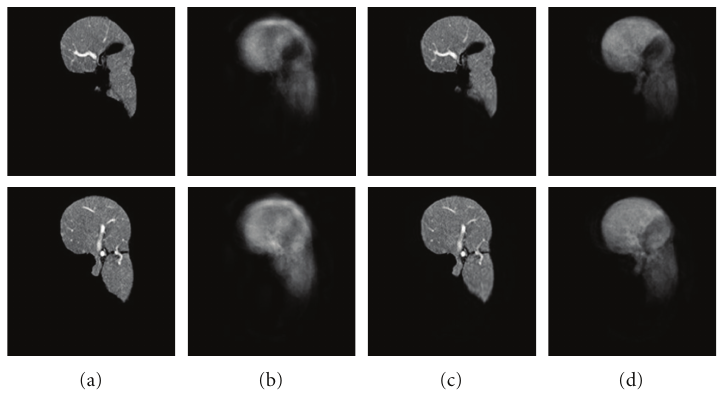
Figure 6: Reconstructed results for two slices of one test sample without shape normalization. (a) Original images. (b) Images reconstructed with 10 × 10 × 4 basis by GND-PCA. (c) Images reconstructed with 100 × 100 × 40 basis by GND-PCA. (d) Images reconstructed by PCA (eigenface method); all 15 available bases are used in the reconstruction.